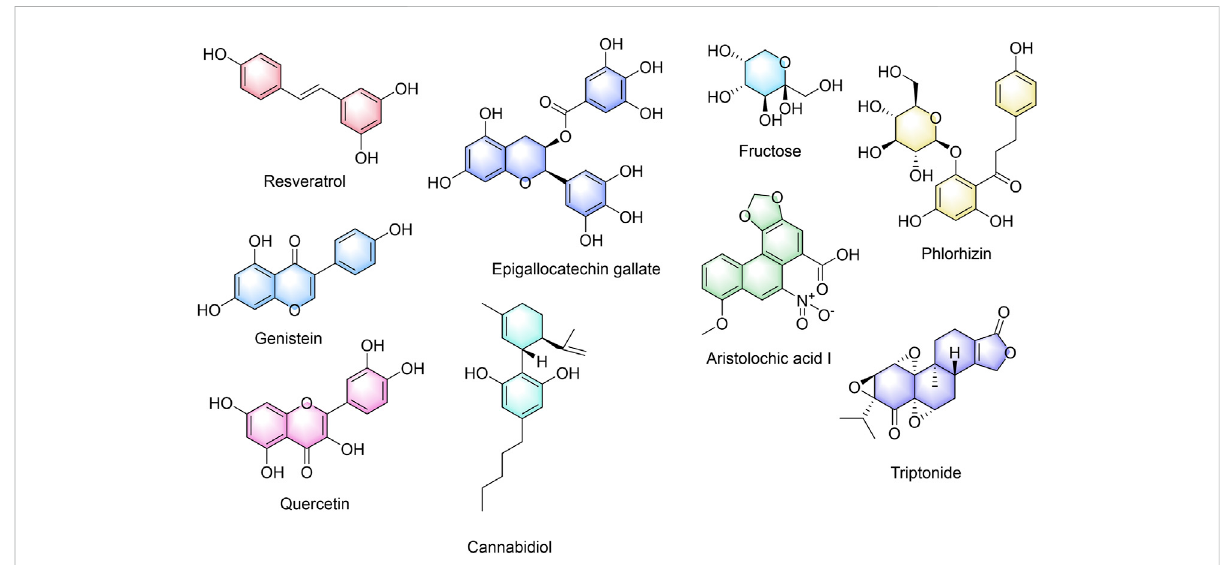
FIGURE 10 Active ingredients of traditional Chinese medicine with a potential effect on